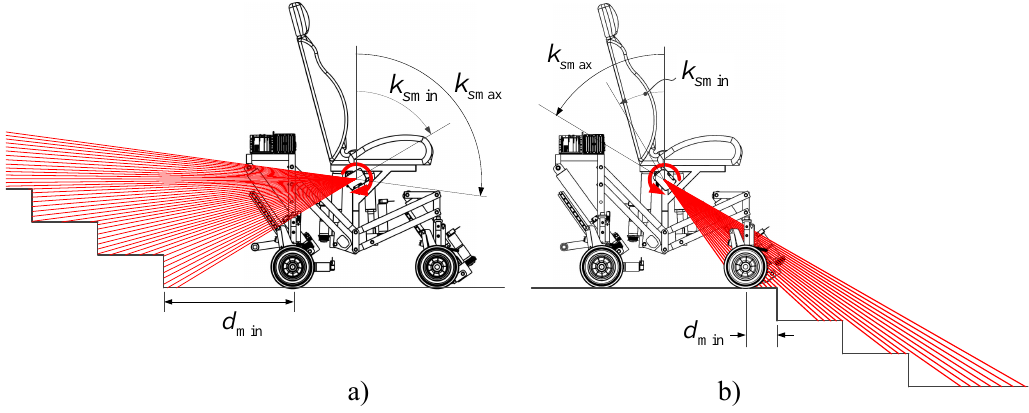
Figure 6. Side view of scanning on the staircase surface; ( a ) before climbing up and ( b ) before climbing